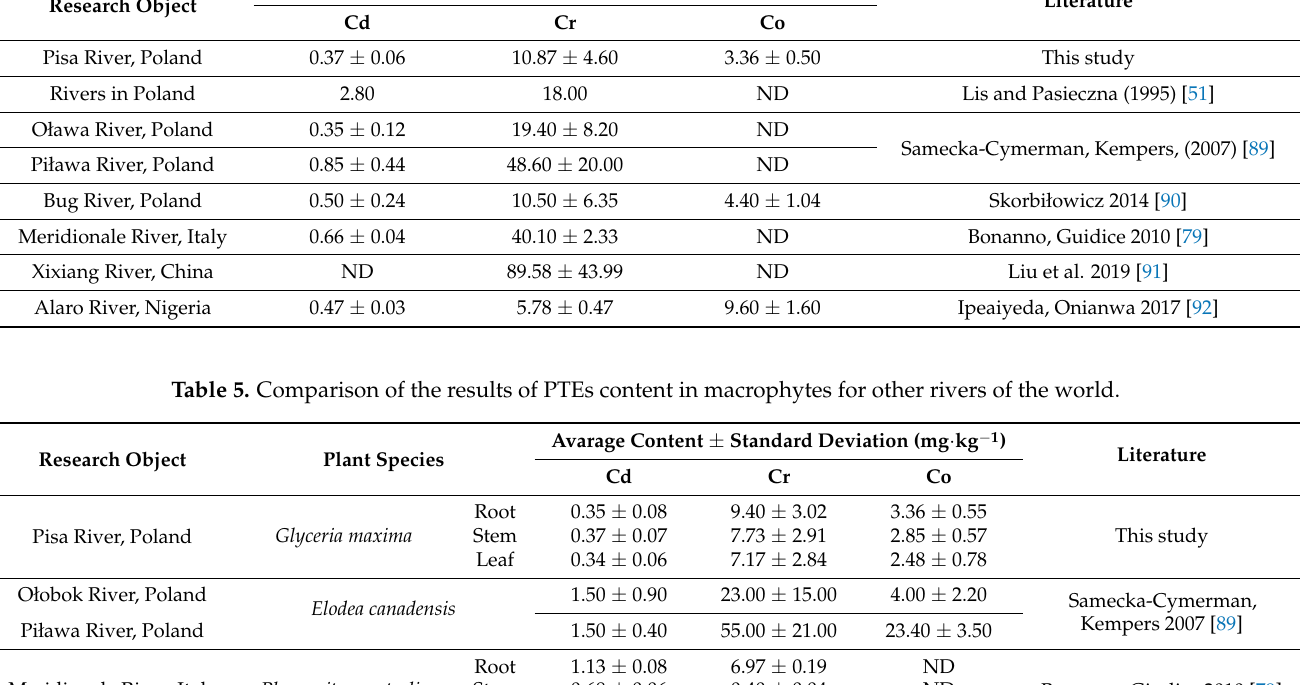
Table 4. Comparison of the results of PTEs content in bottom sediments for other rivers of the world. Research Object